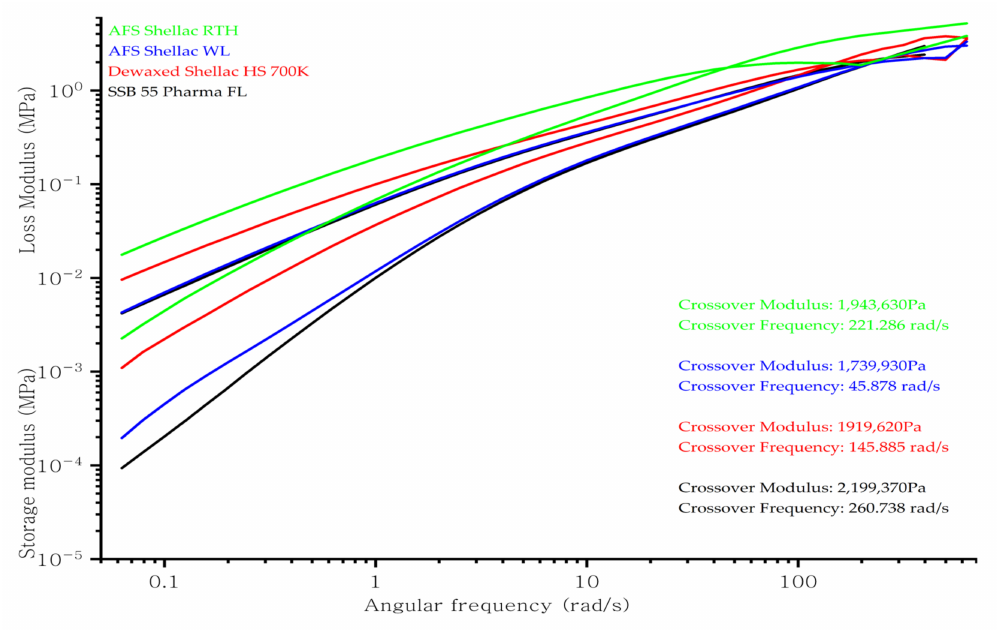
Figure 4. The storage modulus and loss modulus versus frequency of various shellac in frequency sweep at 70 ◦